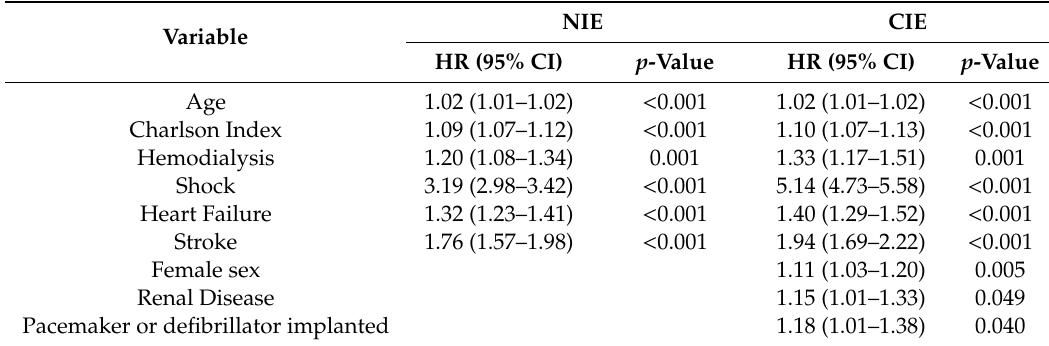
Table 5. Multivariable logistic regression analysis for mortality associated with nosocomial infective endocarditis and community-acquired infective